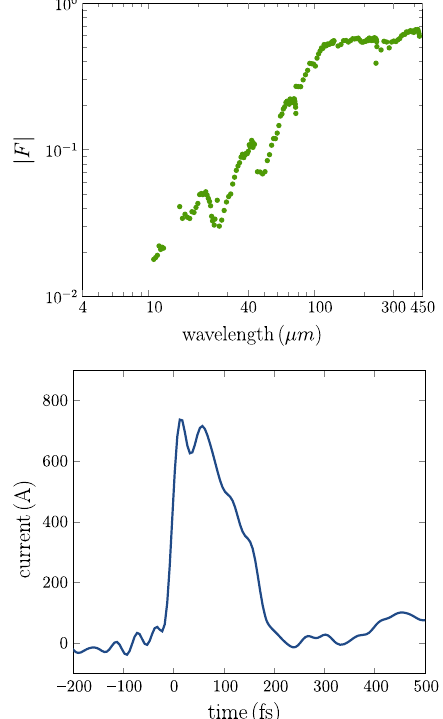
coherent radiation intensity spectrometer (CRISP4). The lower figure presents the reconstructed temporal profile of the electron bunch for the 13.5 nm